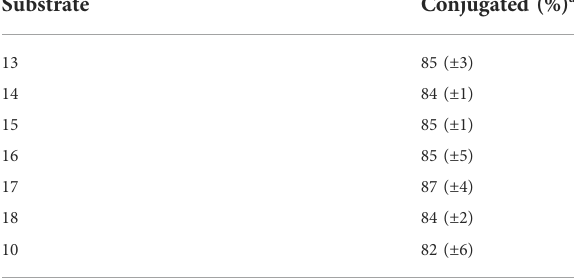
TABLE 2 Percentage of conjugated and unlabeled sortase sites on Biotin – CTB – LPETGA after 2 h.